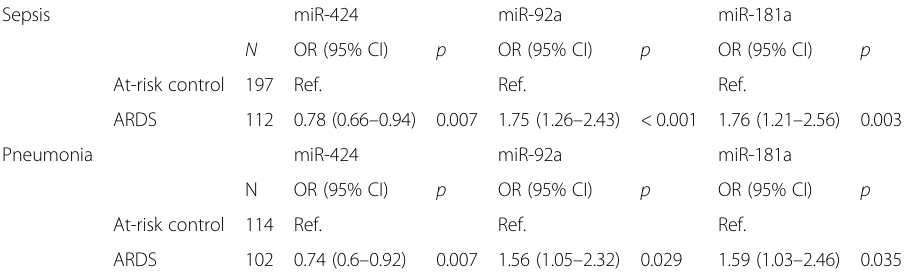
Table 3 Stratification analysis of miRNA associations with ARDS in validation cohorts Sepsis miR-424 miR-92a miR-181a N OR (95% CI) p OR (95% CI) p OR (95% CI) p At-risk control 197 Ref.